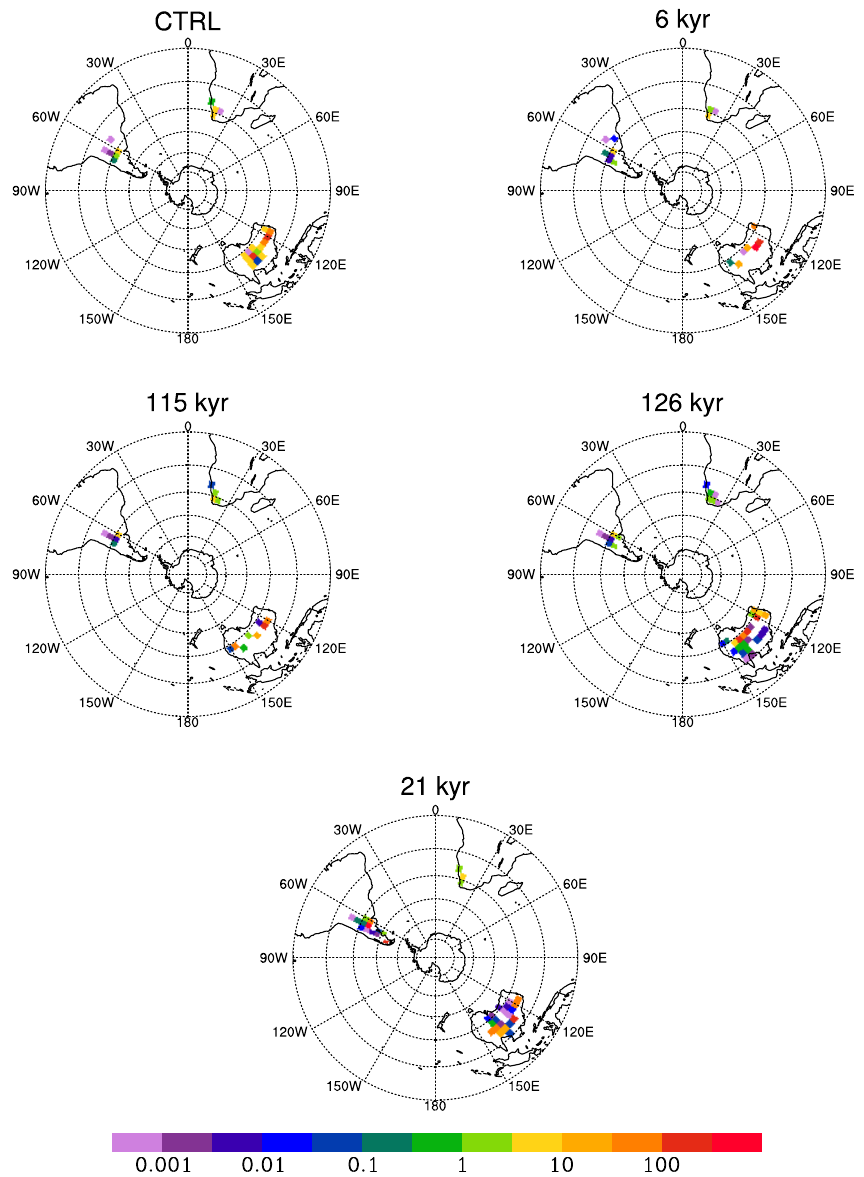
Figure 3. Mean Southern Hemisphere dust emission flux for the CTRL, 6, 115 and 126kyr as well as LGM (21kyr) simulations (in units of gm − 2 yr − 1